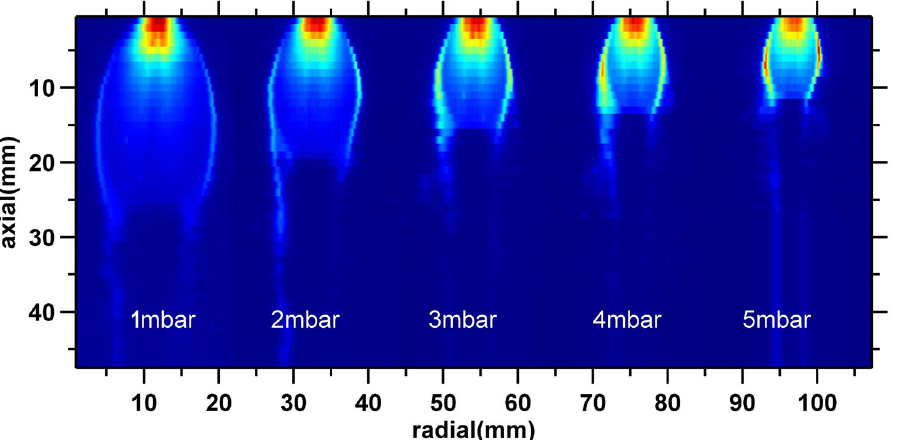
Figure 6. Scattering from the clusters present in the jet operating at five different values of background pressures and same nozzle pressure (4 bar). Individual images of jet are generated by stitching the horizontal stripes of Rayleigh scattering intensity at different distances from the nozzle. Each strip is an average of 100 frames generated from 100 individual jet pulses. The axial resolution of the data is 1 mm (given by scanning step of manual translation stage) and the radial resolution of data is 130 µ m from the pixel size of ICCD. The colorbar in the image are scaled to absolute values of C RS . The image of jet is 0.5 mm thick slice of the jet on the axial